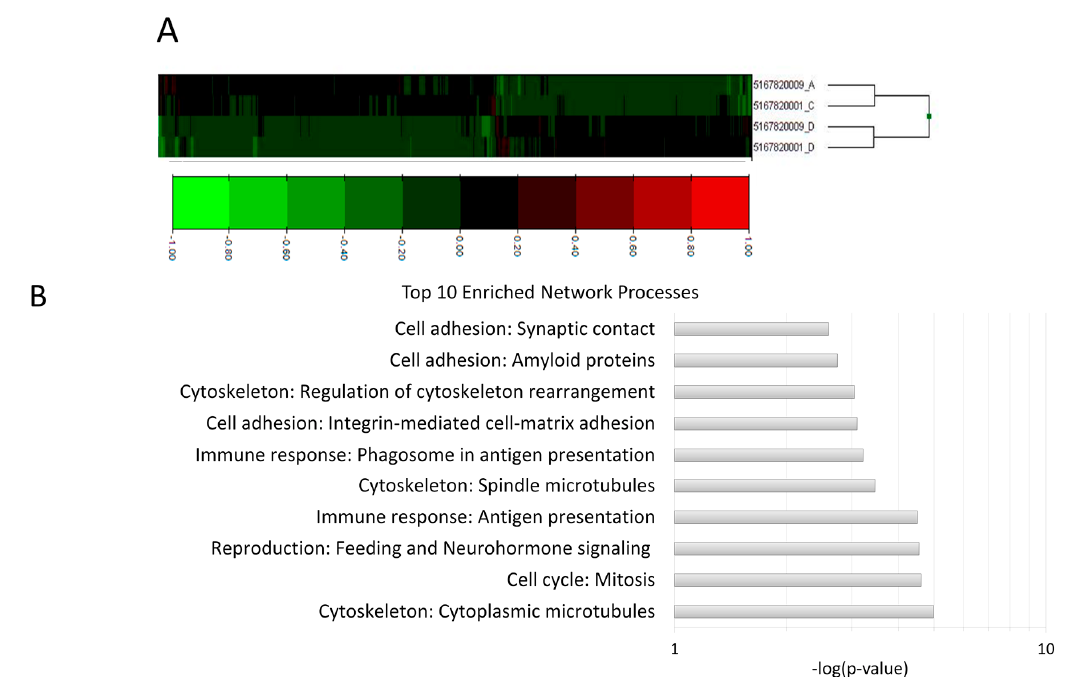
Figure 1. Heatmap of the differentially expressed genes in CBA/SIV+ and SUC/SIV+ used for MetaCore analysis and the top enriched process networks of those genes. ( A ) Heat map shows all 709 genes differentially expressed in CBA/SIV+ compared to SUC/SIV+. Differentially expressed genes were defined as the top one percent and bottom one percent of all genes detected in the microarray analysis. From those genes, only those in which both CBA/SIV+ animals had gene expression higher or lower than both SUC/SIV+ animals were used in process network analysis. Numbers 5167820009_D and 5167820001_D refer to SUC/SIV+ animals; ( B ) Top ten process networks enriched in differentially expressed genes in CBA/SIV compared to SUC/SIV macaques. Larger bars indicate greater significance.